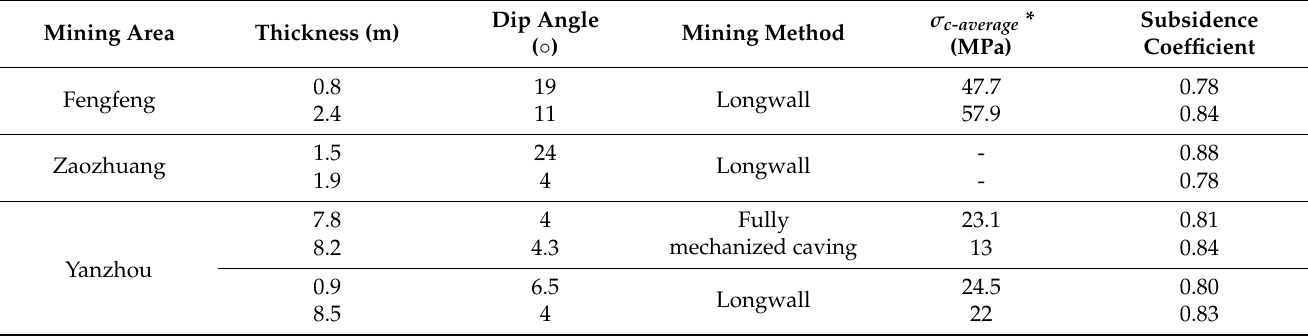
Table 2. The measured subsidence coefficients of neighboring coal